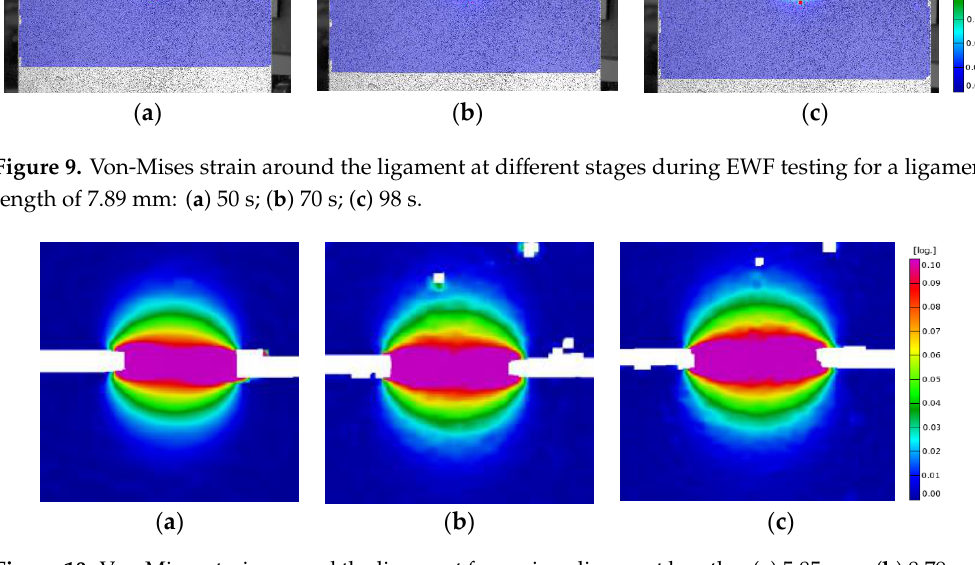
Figure 10. Von-Mises strain around the ligament for various ligament lengths: ( a ) 5.85 mm; ( b ) 8.79 mm; ( c ) 13 mm.